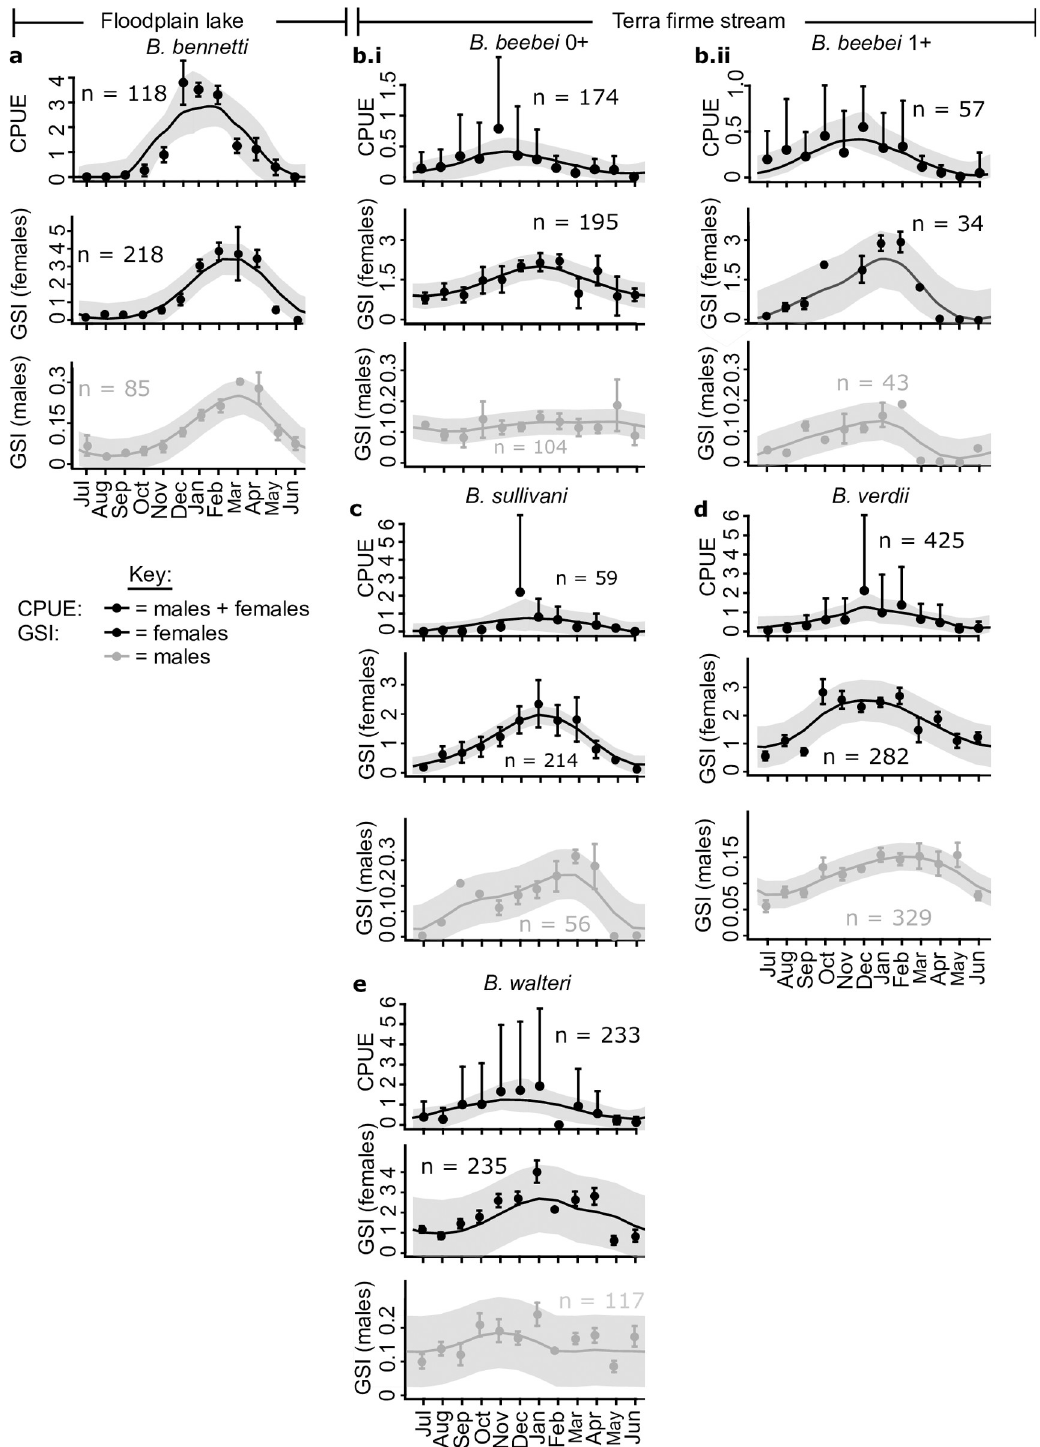
Fig 8. Circannual variation in capture per unit effort abundance of spawning capable adults (gonad Stages 3+4) and gonadosomatic index for all sexed individuals (females and males at gonad Stages 2–5) of five species of Brachyhypopomus . Dots and error bars represent monthly means with +/- 1 standard deviation (only one error bar is provided where plot is congested). Black line and grey shaded area represent spline fit with upper and lower 95% spline confidence intervals.